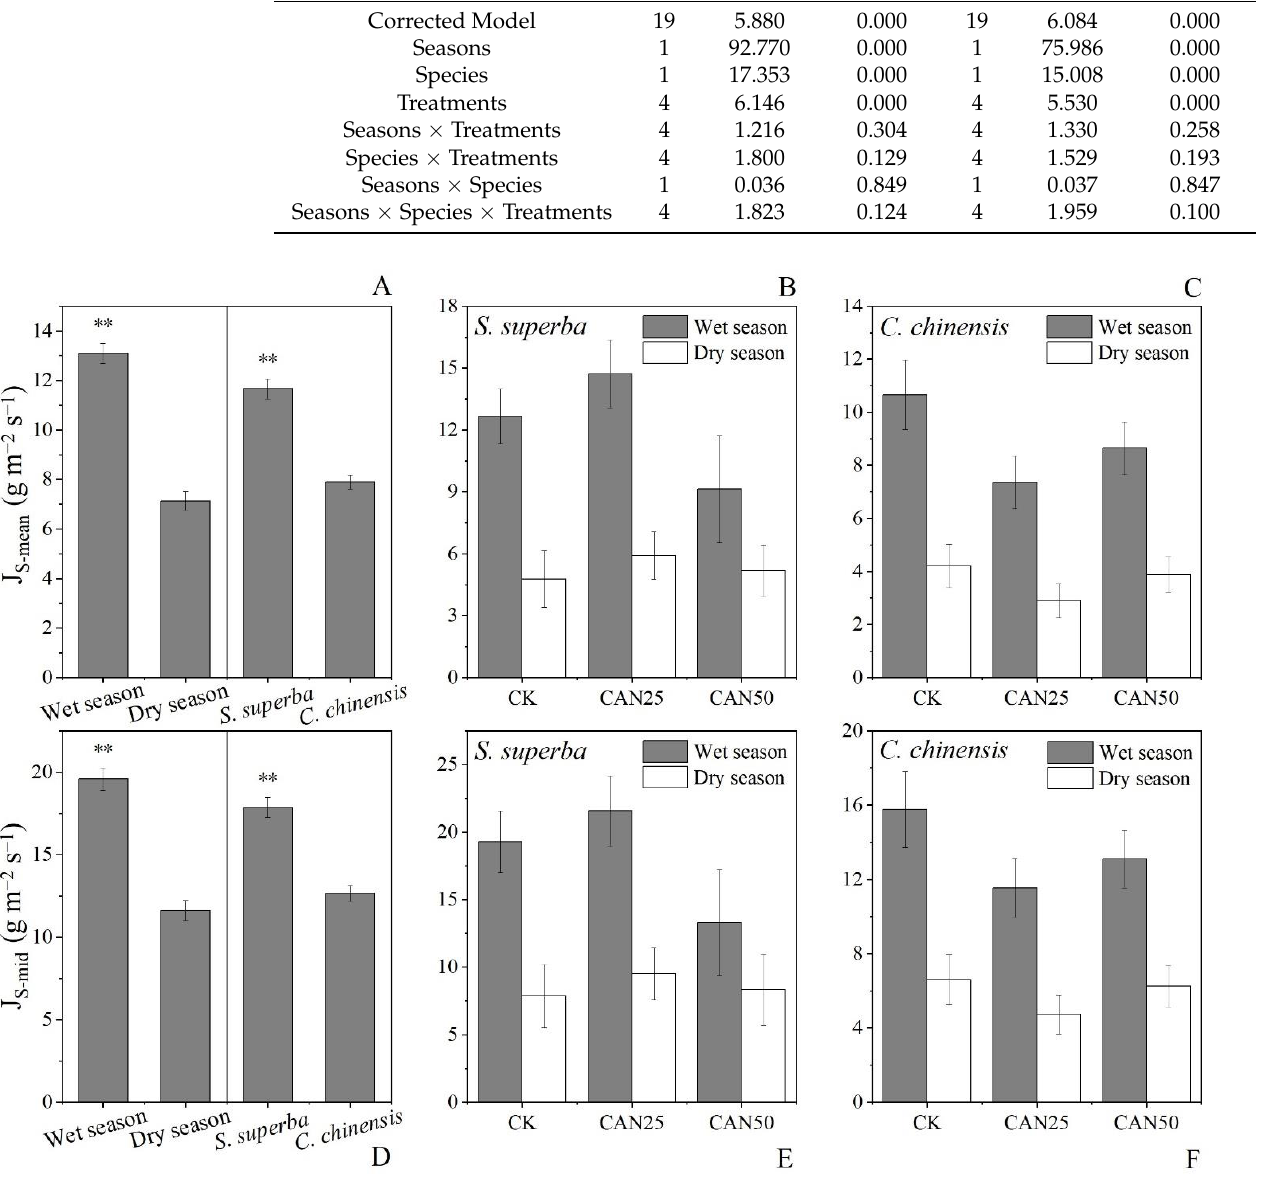
Figure 3. Daily mean J S (J S-mean ) and mid-day J S (J S-mid ) under different seasons and speciesv ( A , D ), J S-mean and J S-mid of S. superba and C. chinensis under nitrogen addition treatments ( B , C , E , F ). The error bars indicate the standard error. Different letters indicate significant differences at p < 0.05; ** indicate significant differences at p < 0.01.